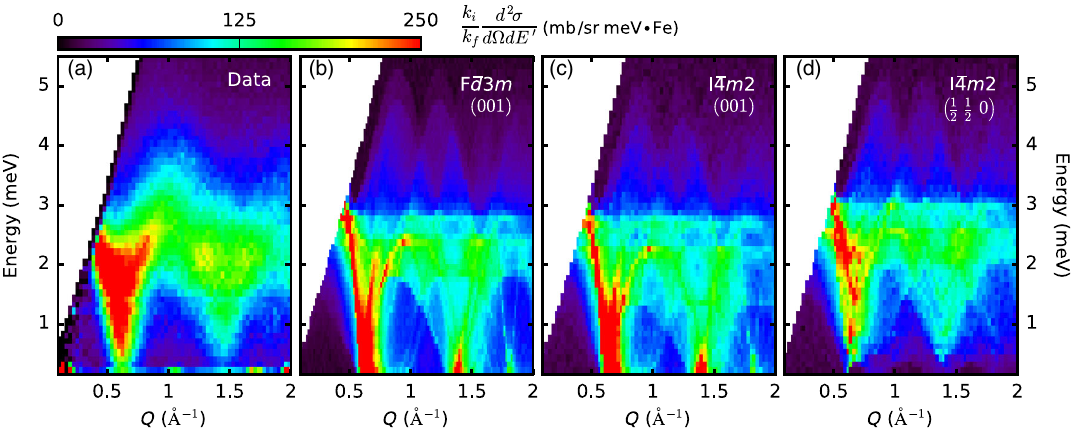
FIG. 12. Spin-wave excitations in candidate magnetic structures for FeSc 2 S 4 . (a) Measured powder-averaged inelastic neutron scattering spectra at 1.6 K and ambient pressure. (b) – (d) Calculated powder-averaged neutron scattering intensity from spin-wave excitations for possible magnetic structures in FeSc 2 S 4 . Heisenberg exchange interactions for each model are listed in Table